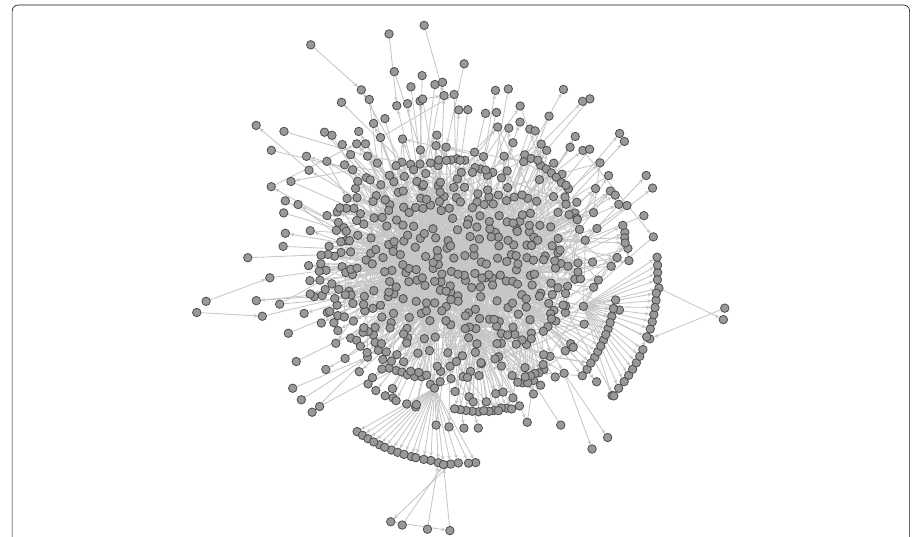
Fig. 5 Pairwise dominance ordering based on dyadic dominance among editors of the Wikipedia article “The Third Man”. The layout has been determined with stress minimization and shows only the largest connected component of the